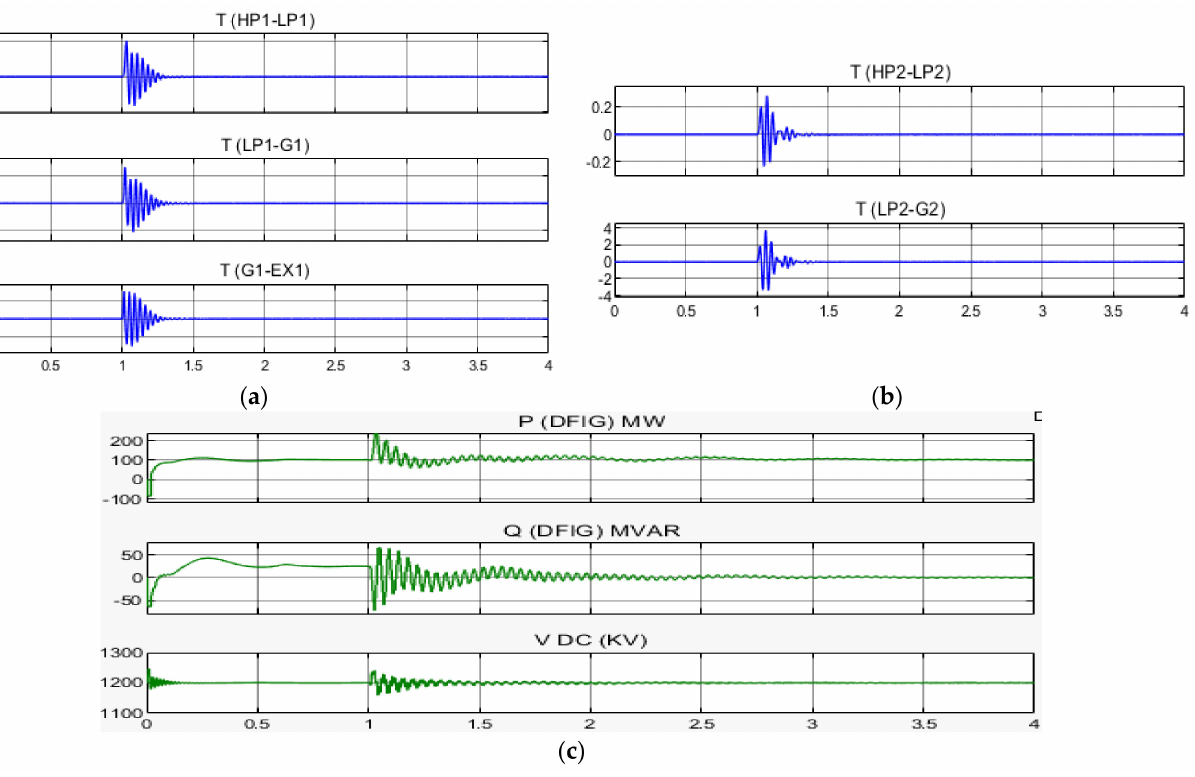
Figure 13. Damping of SSR oscillation in synchronous generation and DFIG with wide-area fuzzy controller with time delay. ( a ): turbine torque of first synchronous generation, ( b ): turbine torque of second synchronous generation, ( c ): V DC , Q, and P of